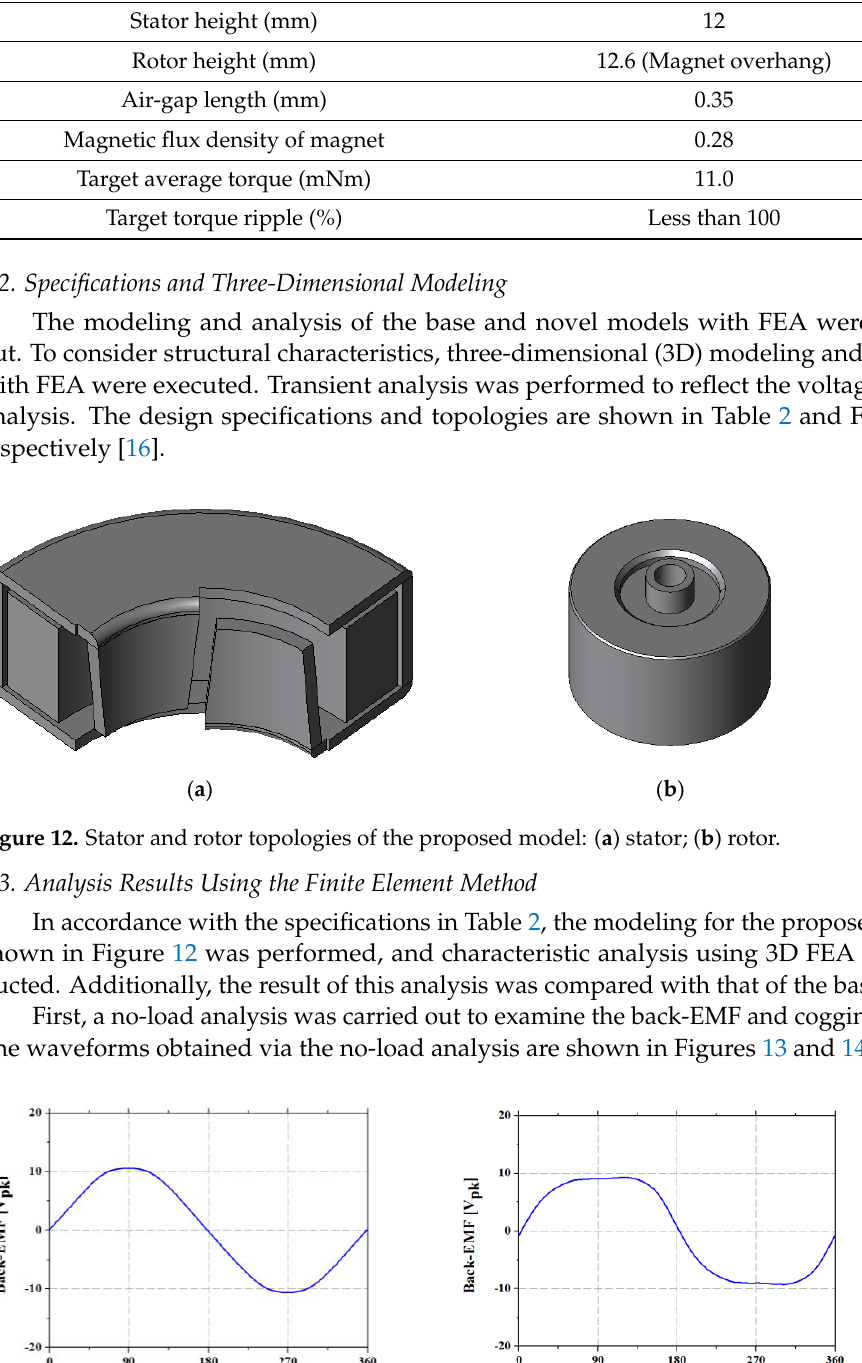
Table 2. Specifications of the target motor.